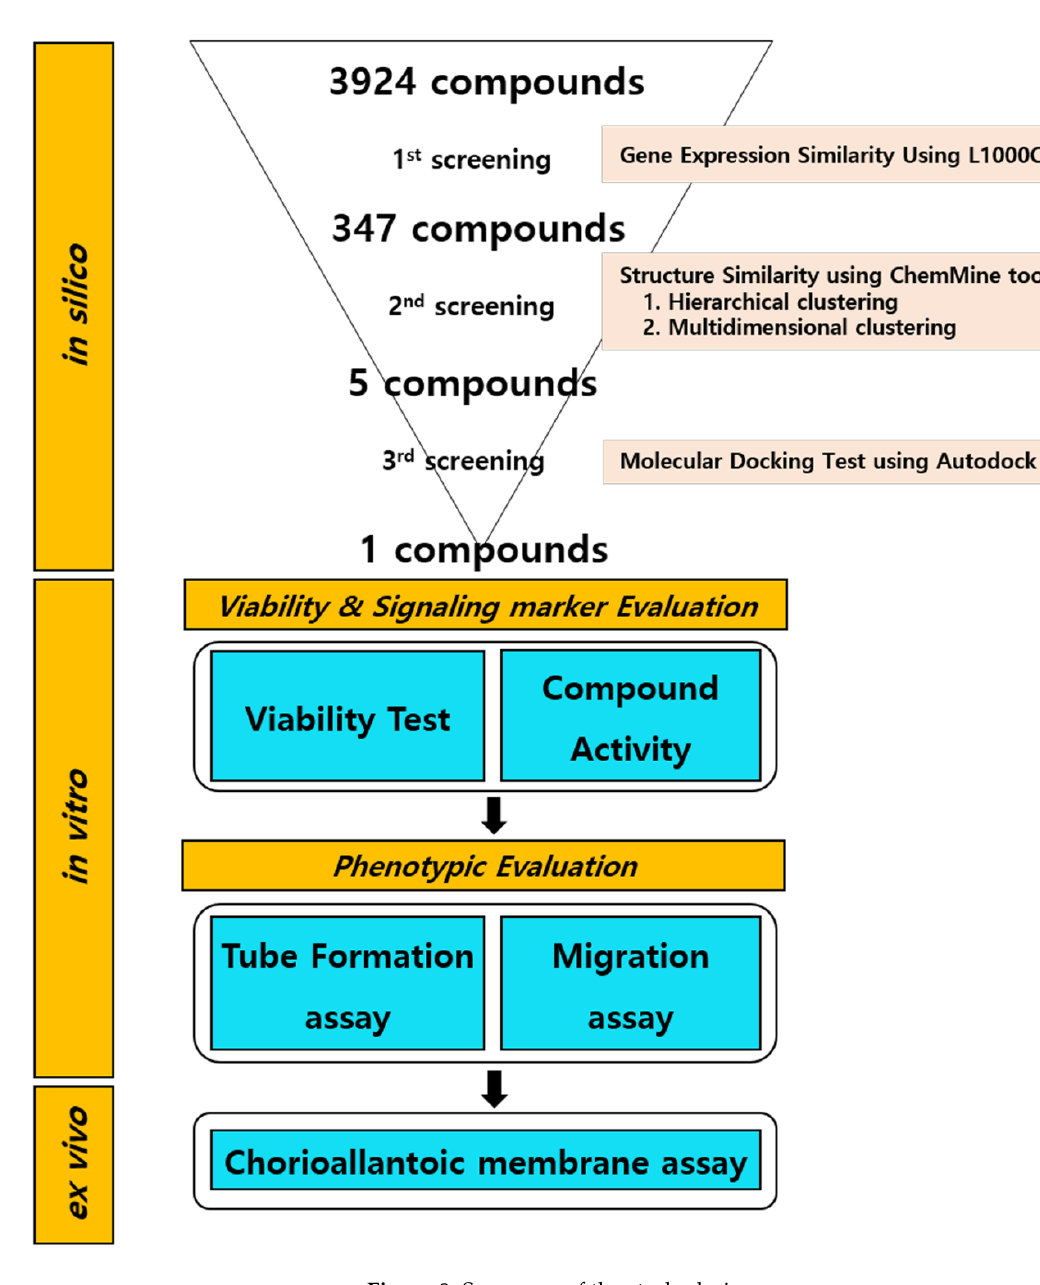
Figure 8. Summary of the study design.